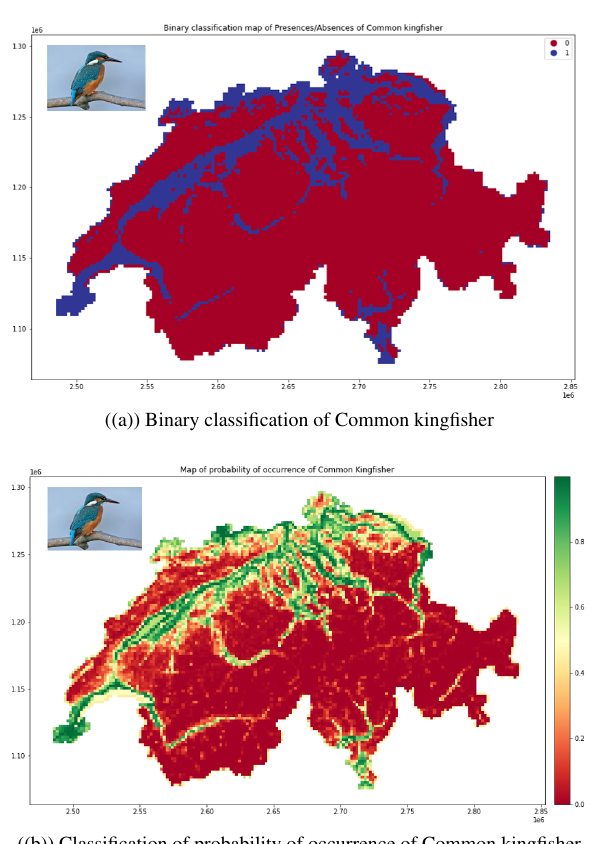
Figure 7. Maps of binary classification (a), and probability of occurrence (b) of Common kingfisher within